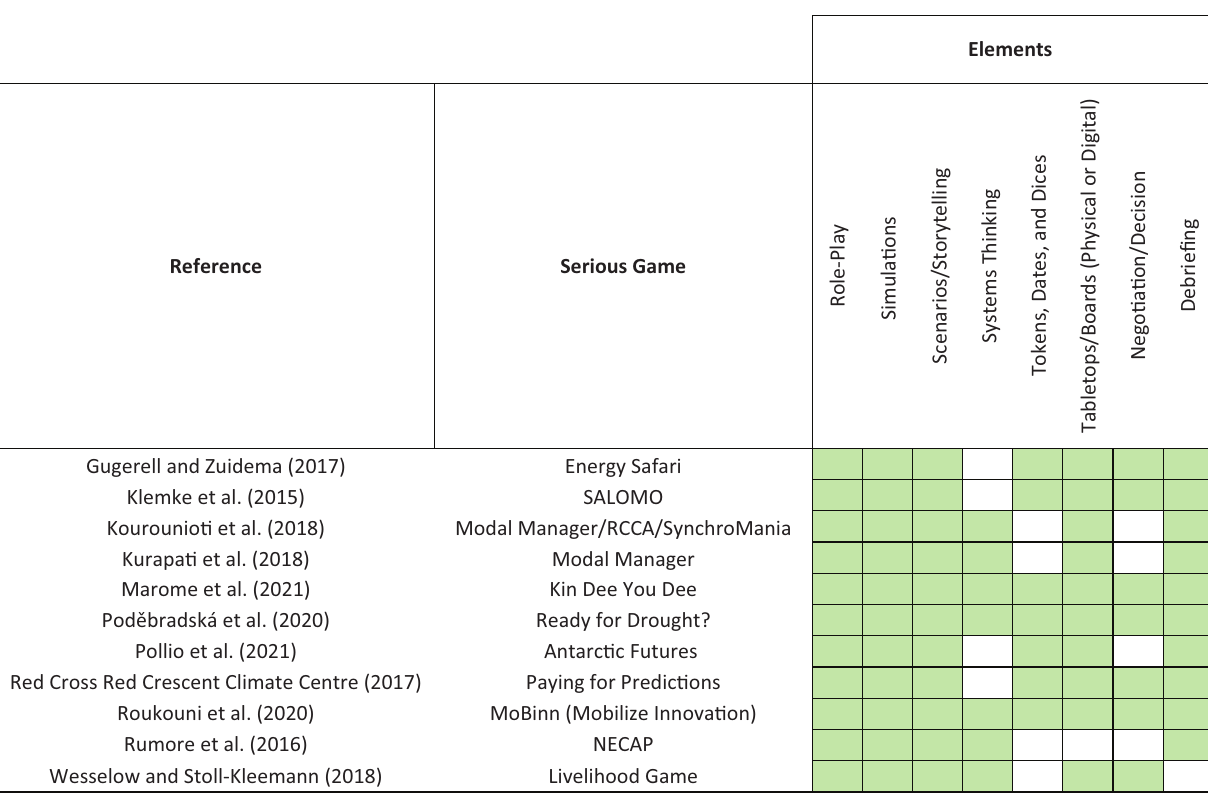
Figure 2. Highlights to inform game design from serious games used for community resilience building in civil systems